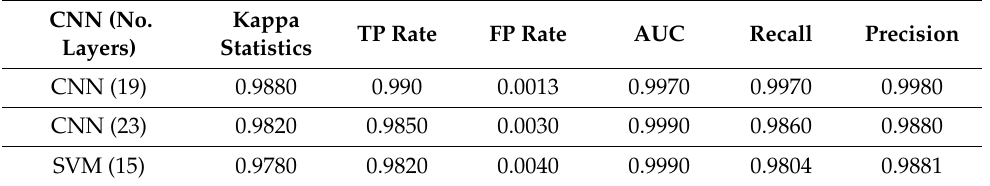
Table 6. Overall accuracy of CNN with respect to the number of layers.